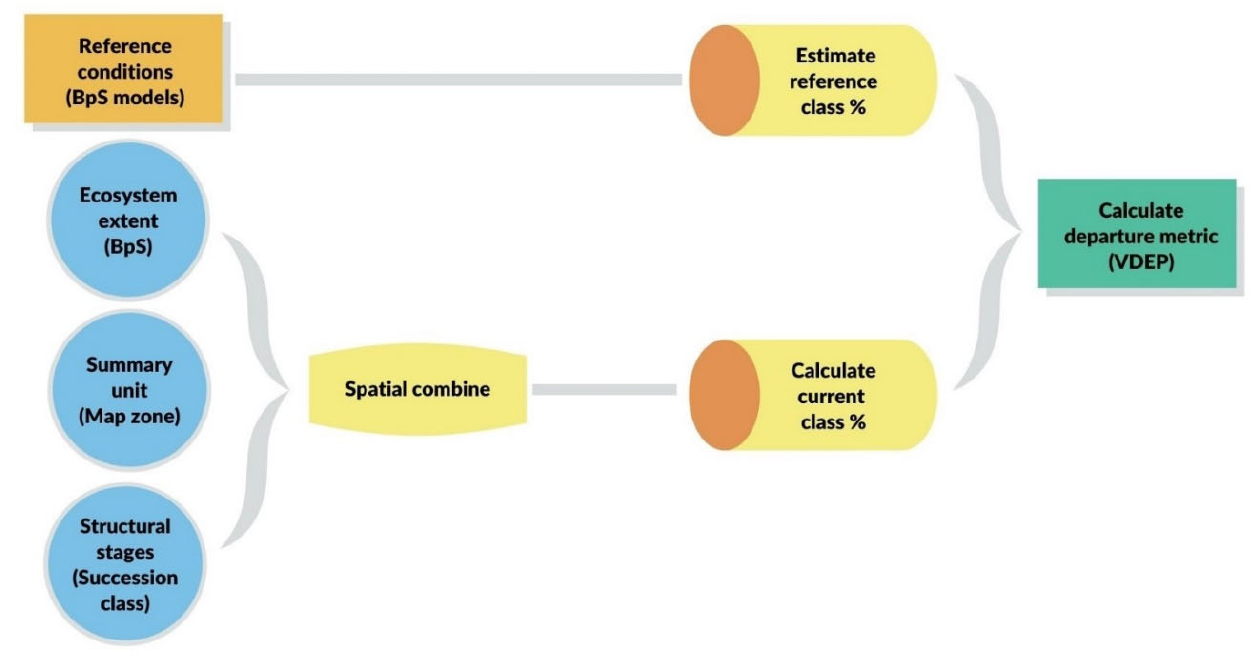
Figure 2. Workflow for calculating VDEP. On the left are the VDEP inputs with LANDFIRE equivalent products in parentheses. The spatial combine is done in a GIS and results in the percentage of current structural stages. The reference amount of each structural stage is estimated from the BpS model results. The current and reference class percentages are compared to calculate departure.